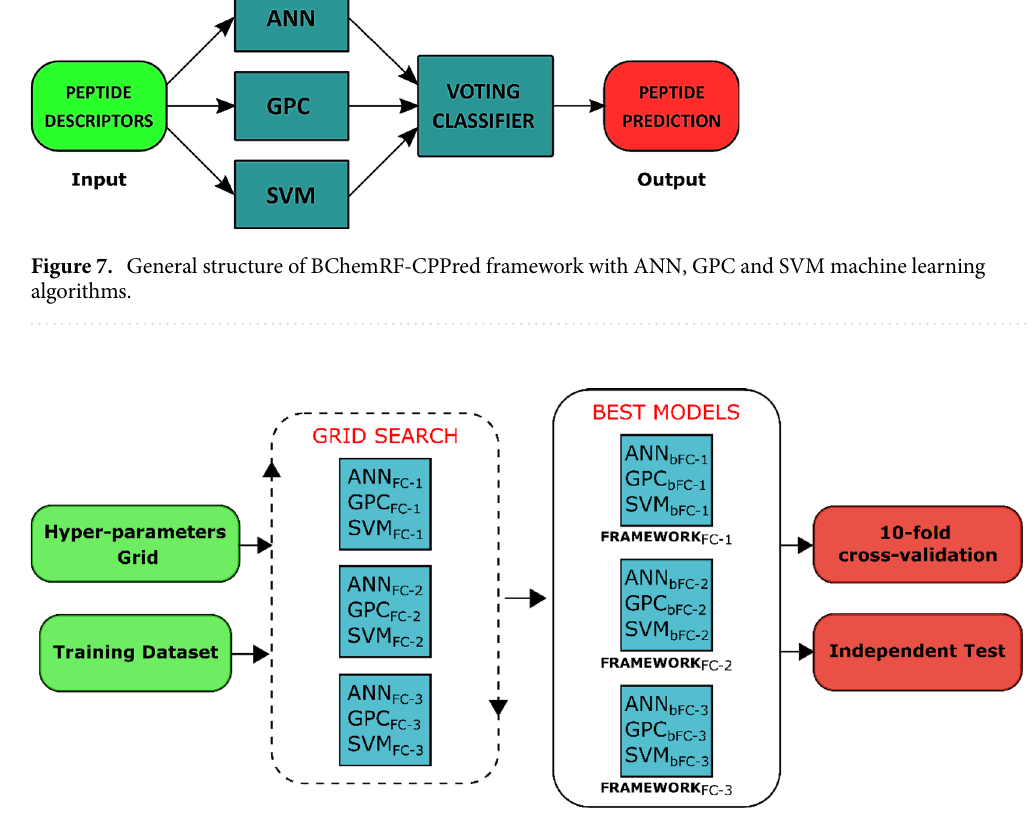
Figure 8. Process of hyper-parameters tuning applied for ANN, GPC, and SVM by FC using Grid Search method. The best models obtained in x -th feature composition (ANN bFC-X , GPC bFC-X , SVM bFC-X ) were used to compose the respective